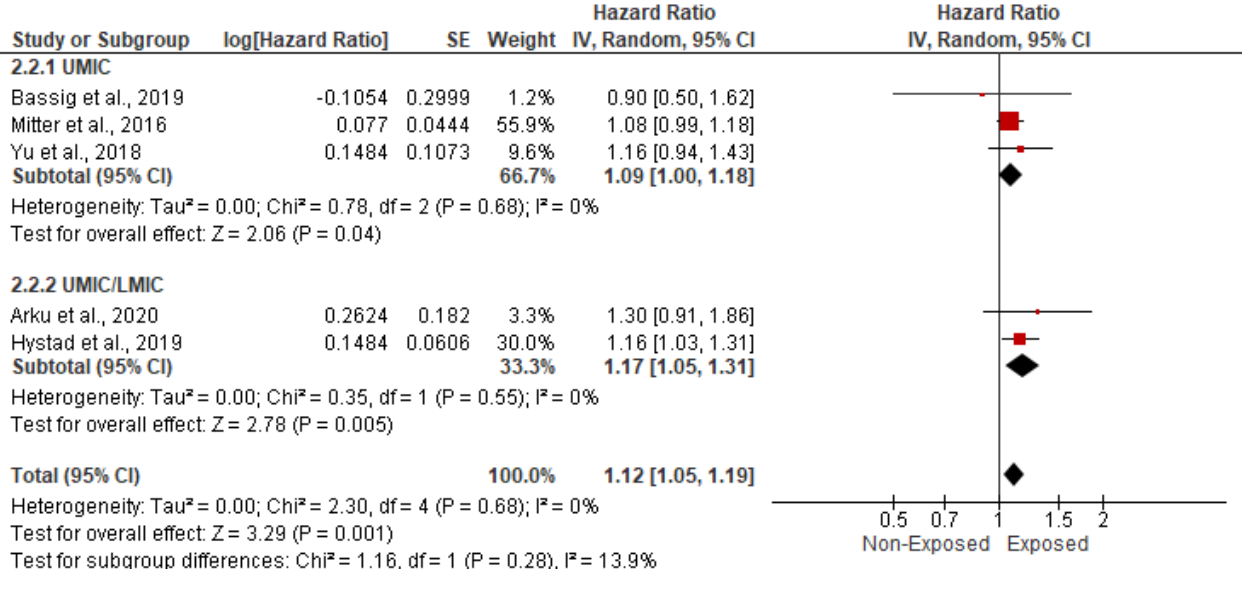
Figure 8. Forest plot of subgroup analysis of the hazard ratio and 95% CI of the association between HAP and cerebrovascular accidents based on income category. The size of the red squares is proportional to the statistical weight of each trial. The gray diamond represents the pooled point estimate. The positioning of both diamonds and squares (along with 95% CIs) beyond the vertical line (unit value) suggests a significant outcome (IV = inverse variance).